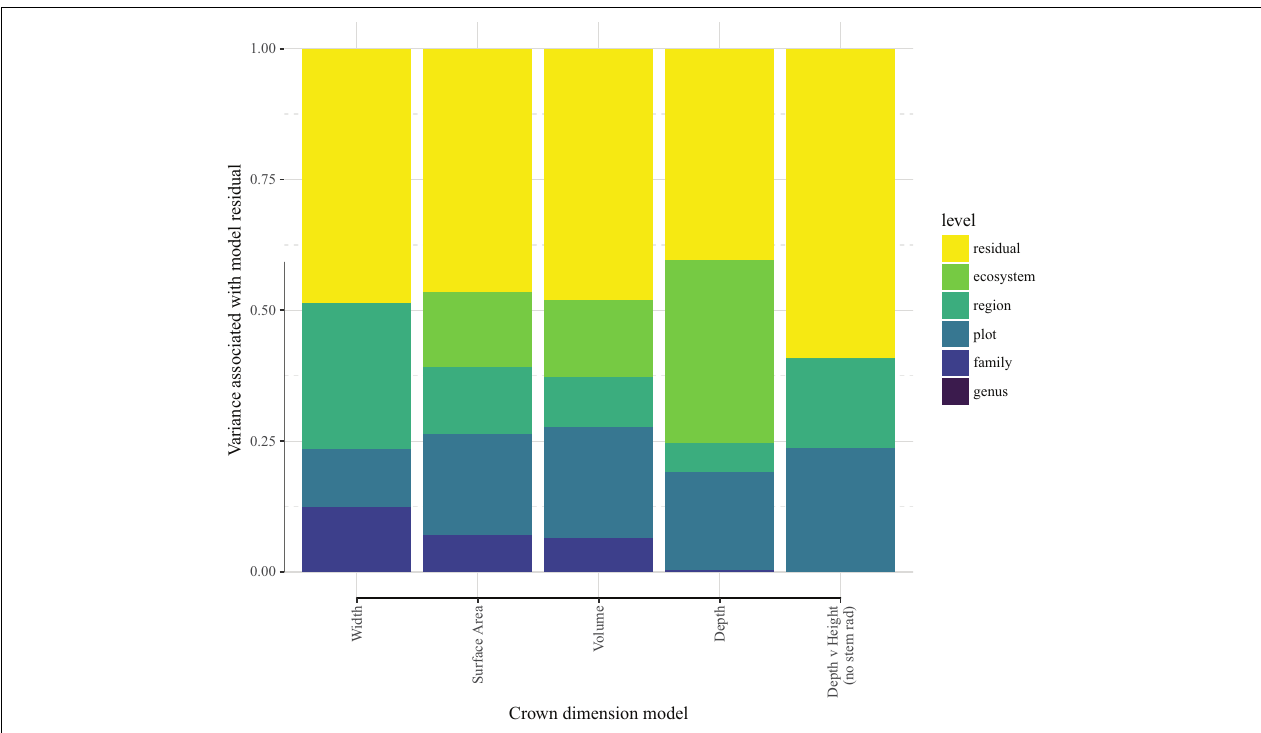
FIGURE 3 | Variance associated with species’ deviation from mean crown scaling relationship. The quantity analyzed here is the mean species residual, or deviation, from the crown _ dimension = β r stem α scaling model. LMM models were re-fit with site as a random effect, and residuals were obtained with the random effects